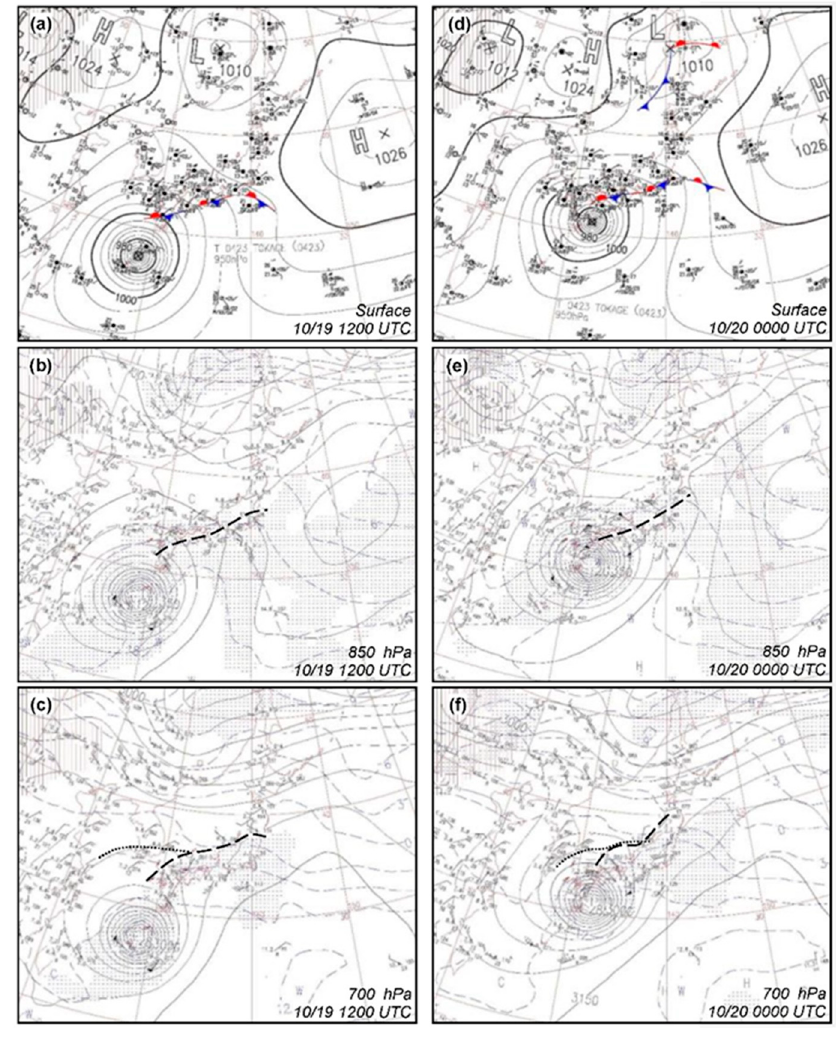
Figure 2. JMA weather maps at ( a ) surface, ( b ) 850 hPa, and ( c ) 700 hPa at 1200 UTC 19 October 2004. Variables analyzed are mean sea-level pressure (MSLP; hPa, isobars every 4 hPa) and fronts in ( a ), and geopotential height (gpm, solid, every 30 gpm), temperature (°C, dashed, every 3 °C), and wet areas with dew-point depression ≤ 3 °C (dotted patches) in ( b , c ). Upper-level troughs/ wind-shift lines near Japan are plotted (thick dashed lines), and the wind-shift line at 500 hPa is also marked (thick dotted line) in ( c ). ( d – f ) These images show the same as ( a – c ), except at 0000 UTC 20 October